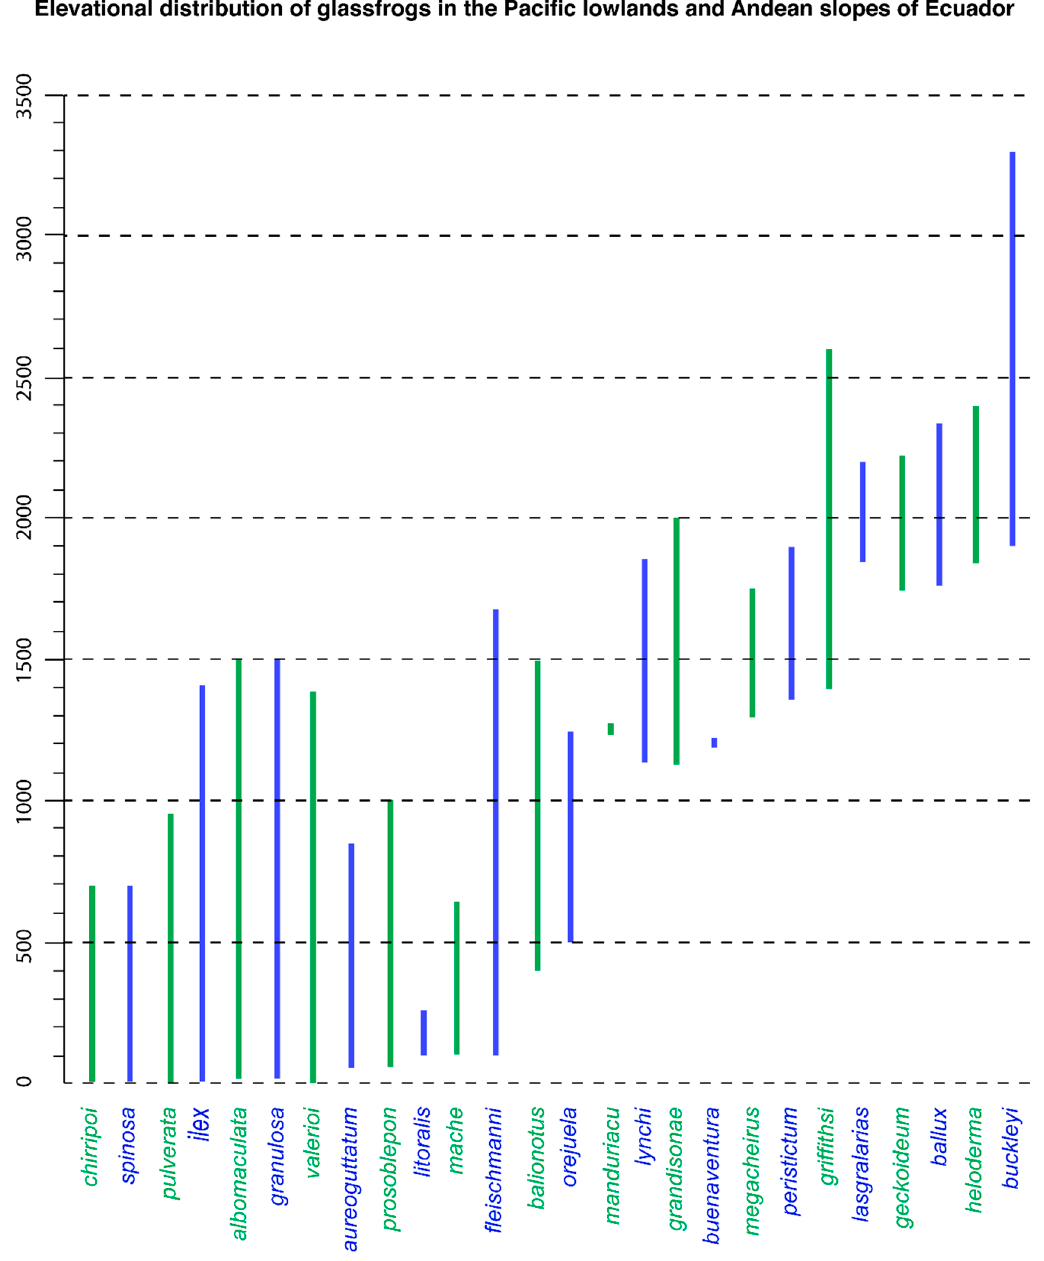
Figure 228. Elevational distribution of glassfrogs found on the Pacific lowlands and western slopes of the Ecuadorian Andes.